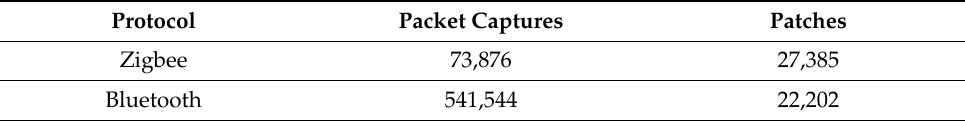
Table 3. Number of packets and patches for each protocol